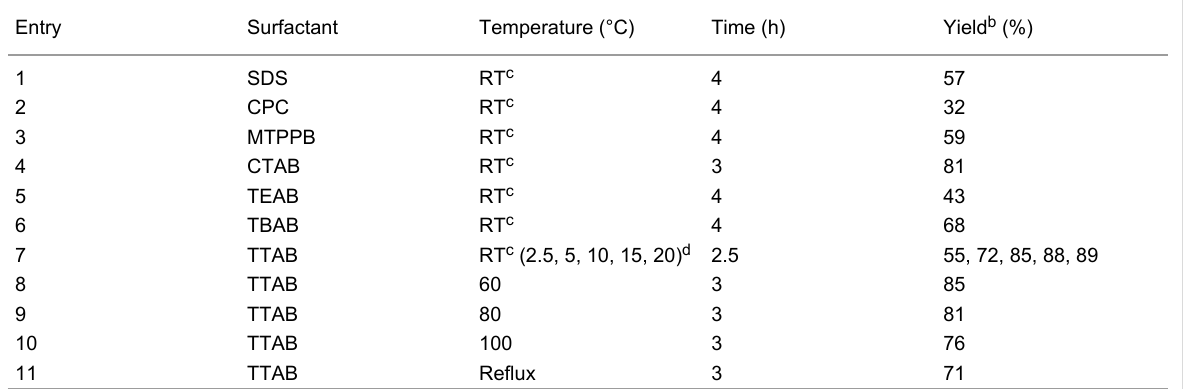
Table 1: Screening of surfactants. a